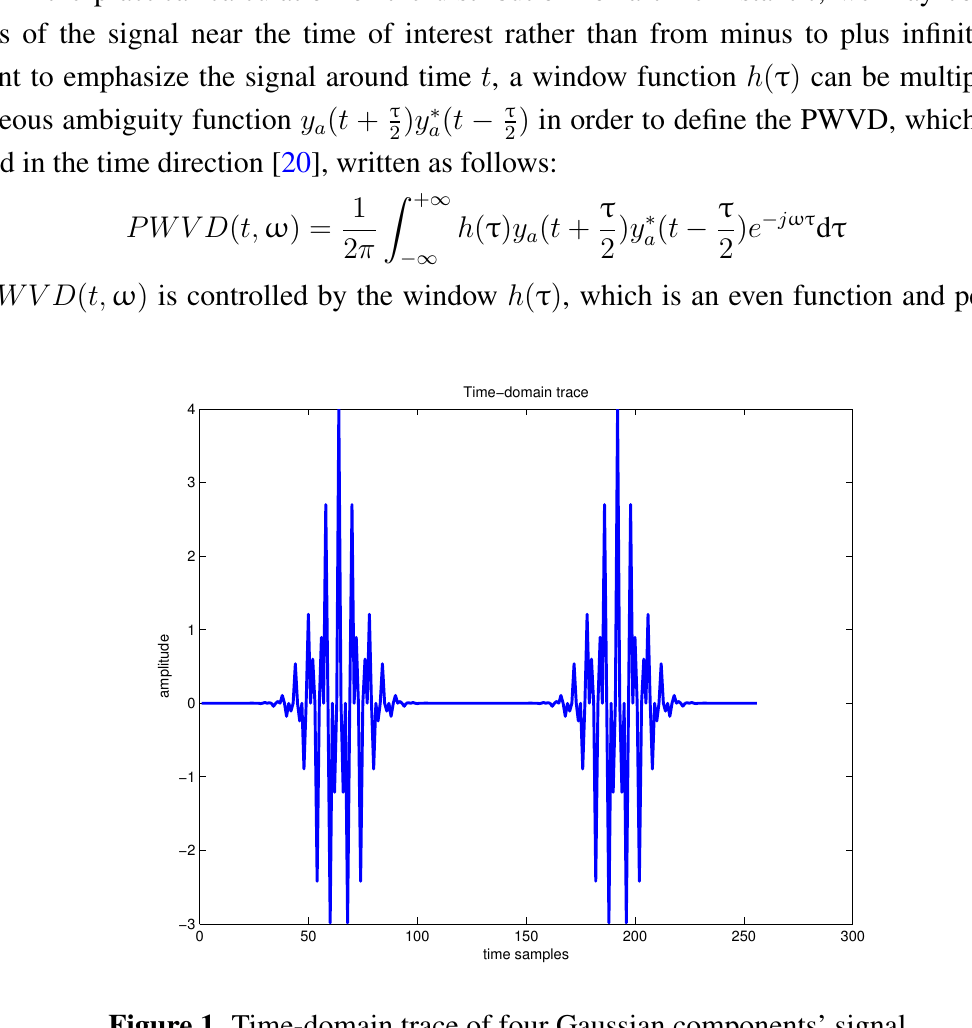
Figure 1. Time-domain trace of four Gaussian components’ signal.